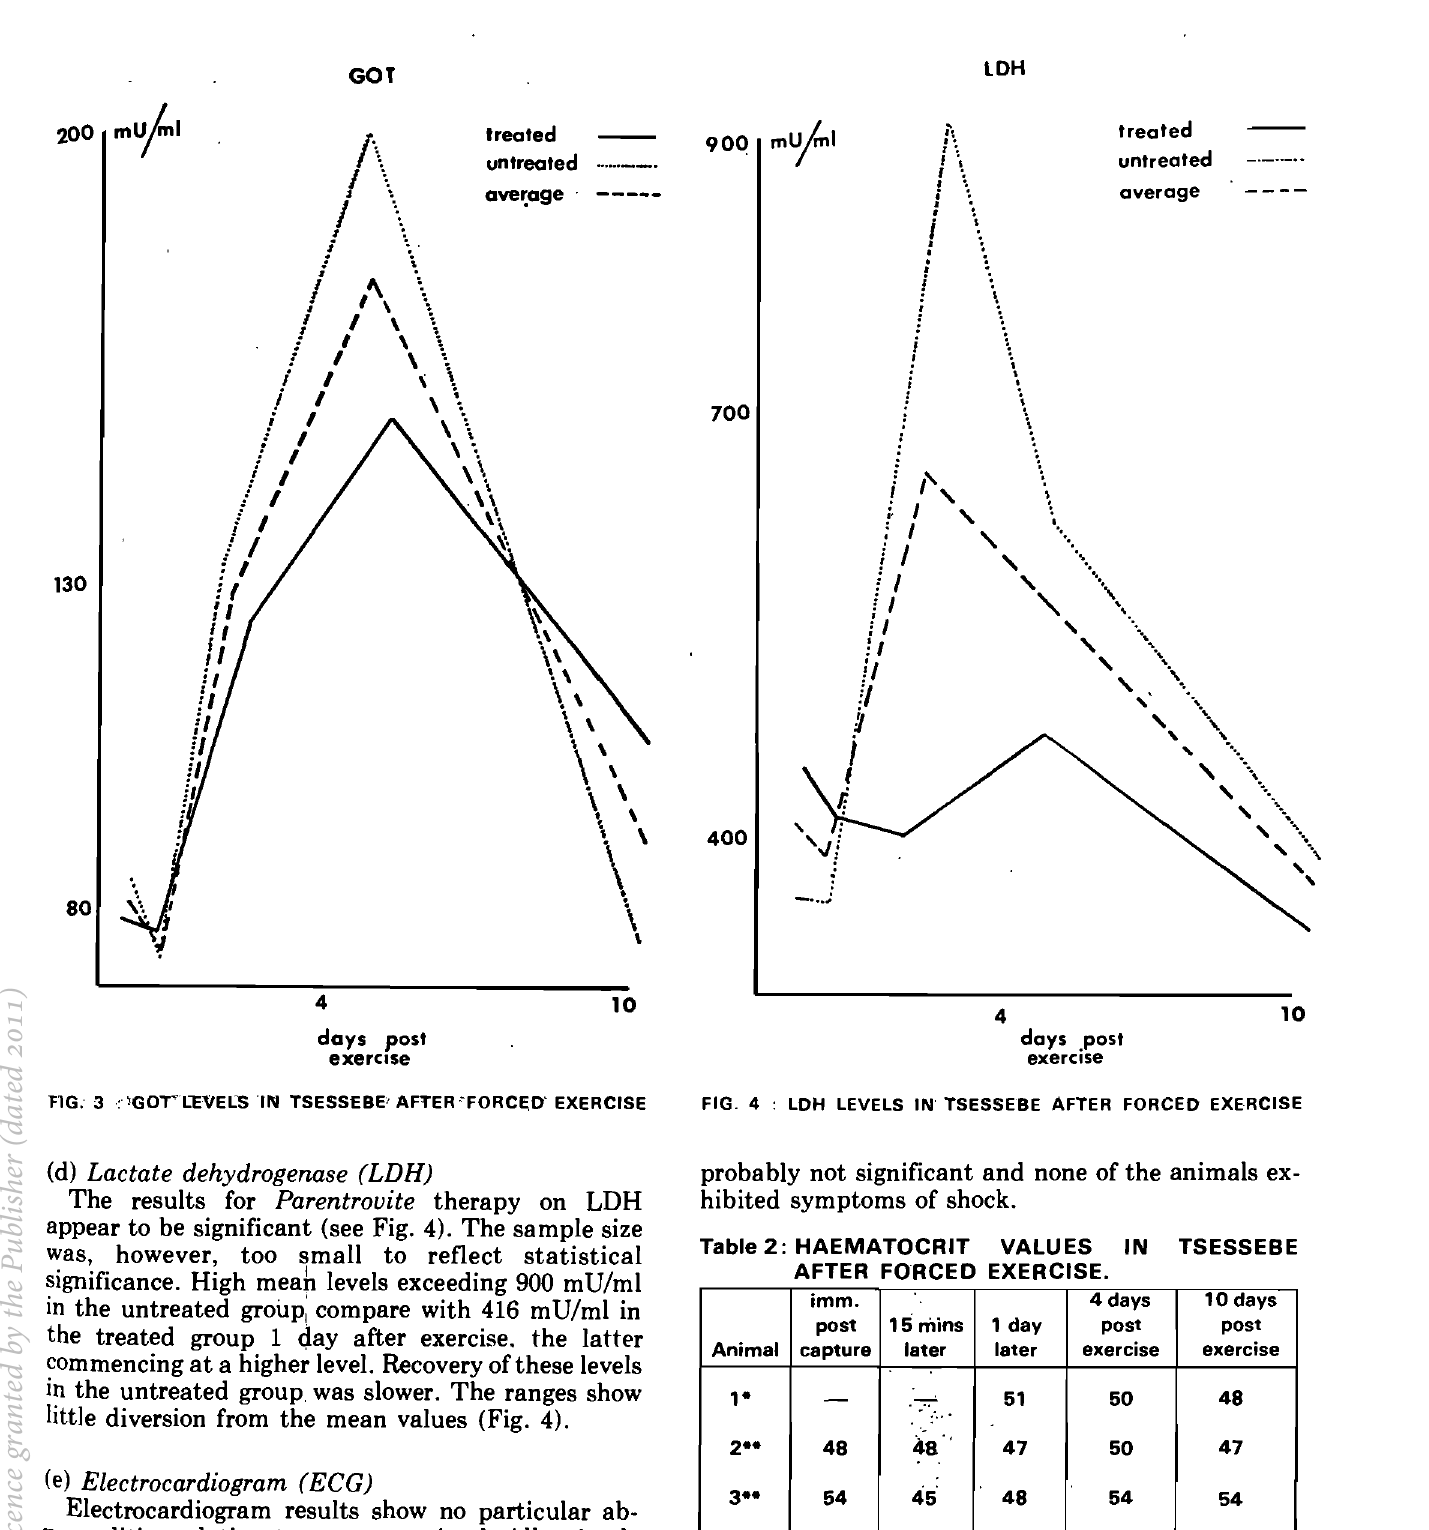
probably not significant and none of the animals ex hibited symptoms of shock. Table 2: HAEMATOCRIT VALUES IN TSESSEBE AFTER FORCED